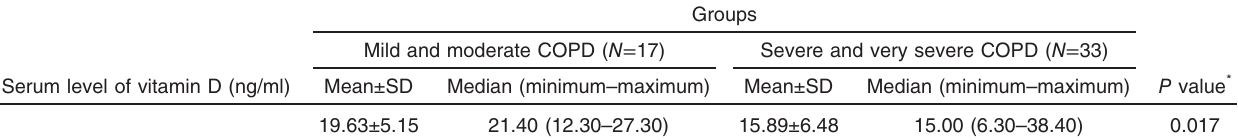
Table 3 Serum level of 25(OH) vitamin D and chronic obstructive pulmonary disease severity Groups Mild and moderate COPD ( N = 17) Severe and very severe COPD ( N = 33) Serum level of vitamin D (ng/ml)